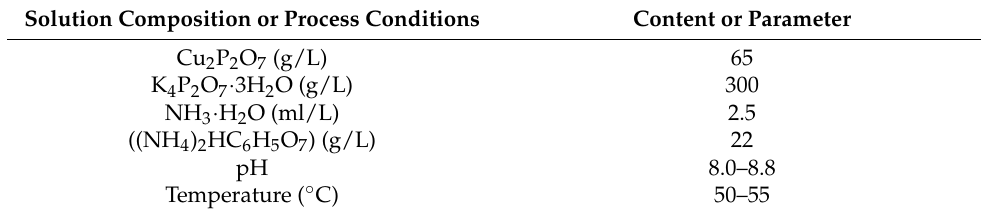
Table 1. Chemical composition of the electroforming bath.